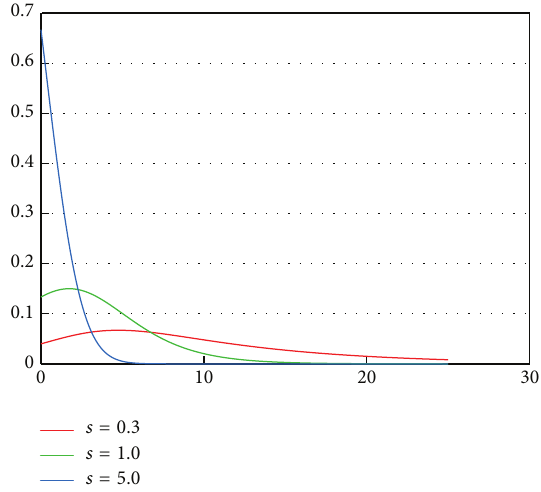
Figure 1: Three parameters Gamma/Gompertz distribution density